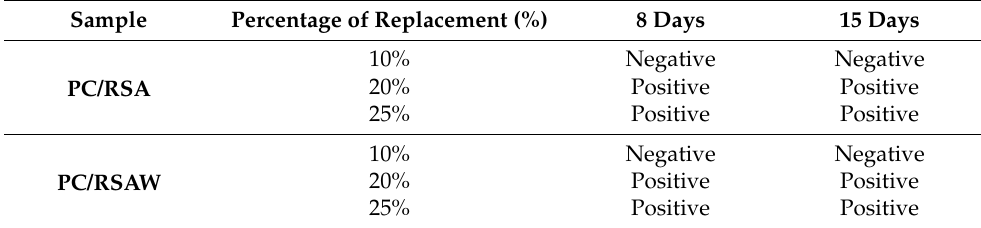
Table 3. Results obtained in the Frattini test of Portland cement/rich straw ash (PC/RSA) and PC/RSAW after 8 and 15 days.